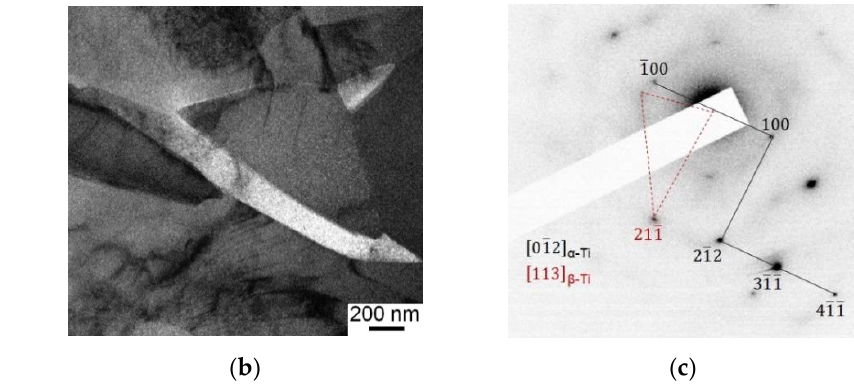
Figure 9. TEM bright- ( a ) and dark-field ( b ) images and an associated SAED pattern ( c ) illustrating the microstructure of the Ti-6Al-4V samples subjected to UIT. The micrographs were obtained at a depth of 75 µm below the treated surface. The dark-field micrographs were obtained with the 211(cid:3364) β-Ti reflection.